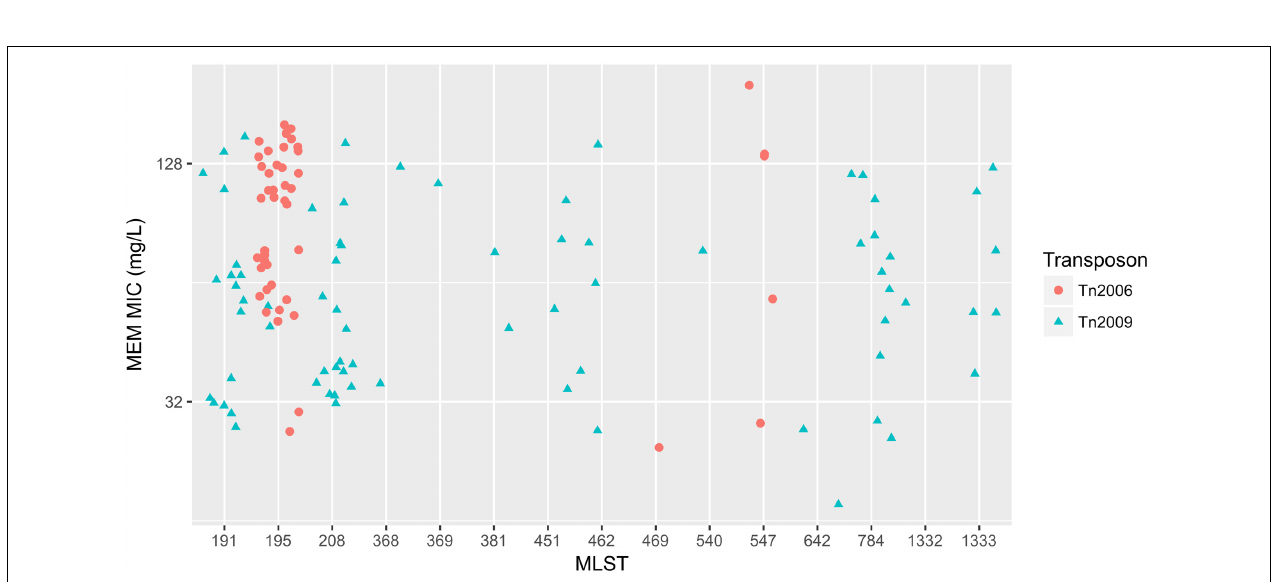
FIGURE 7 | The relationship between meropenem MICs and Transposons carrying bla OXA − 23 in A. baumannii . The x -axis showed the MLST of strains in A. baumannii . The y -axis presented meropenem MICs. Red circle: Tn2006; cyan triangle: Tn2009.